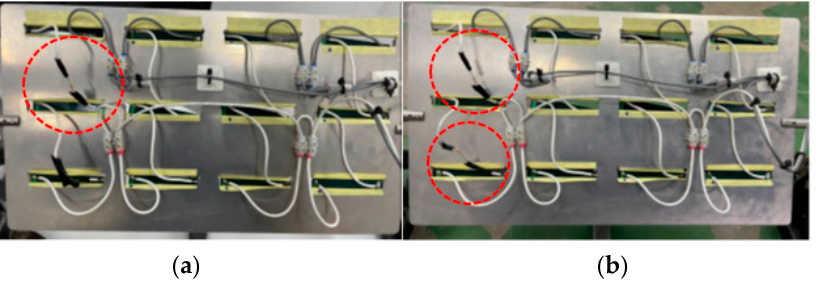
Figure 5. ( a ) Case 3: one 1- Ω ; and ( b ) Case 4: two 1- Ω resistors connected in series to the PV cells.